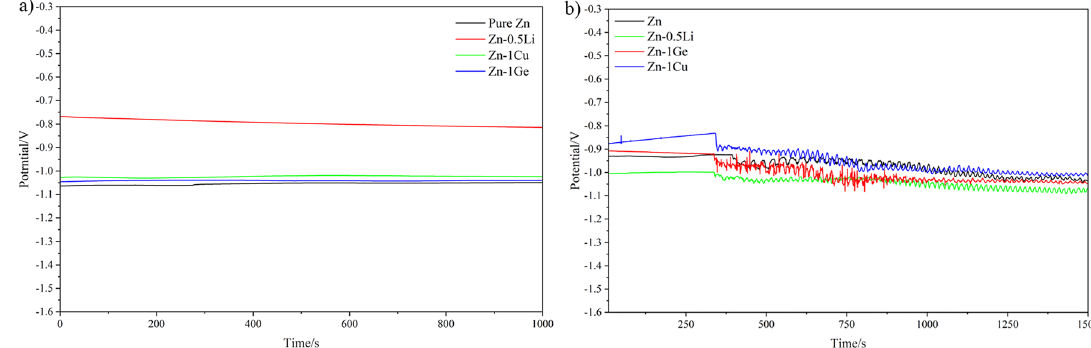
Fig. 8 OCP curves of pure Zn, Zn-0.5Li, Zn-1Cu and Zn-1Ge in Hank ’ s solution: ( a ) without friction and wear; ( b ) with friction and